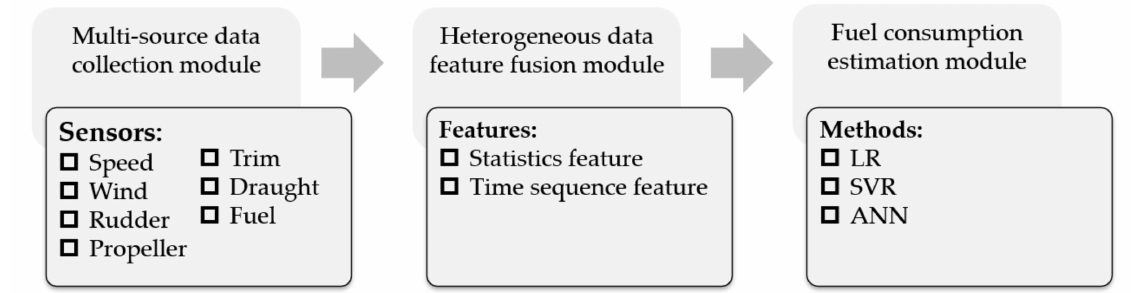
Figure 1. Overview of fuel consumption estimation